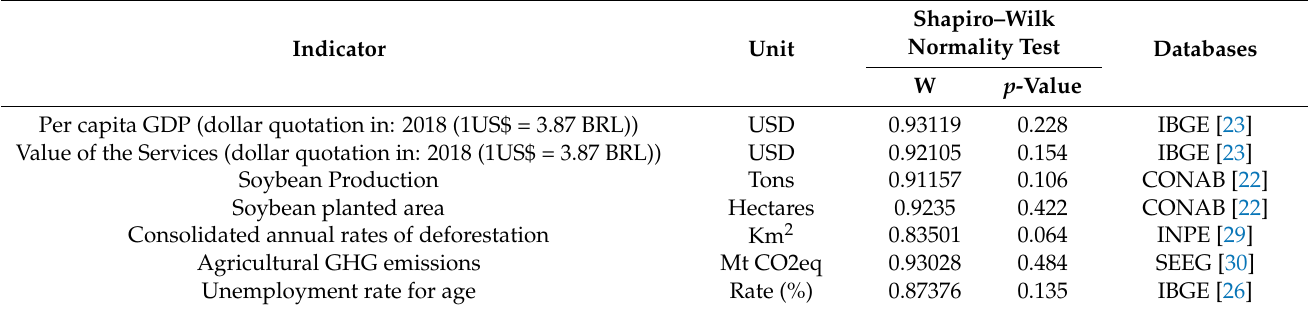
Table 13. The data sources for the Legal Amazon indicators